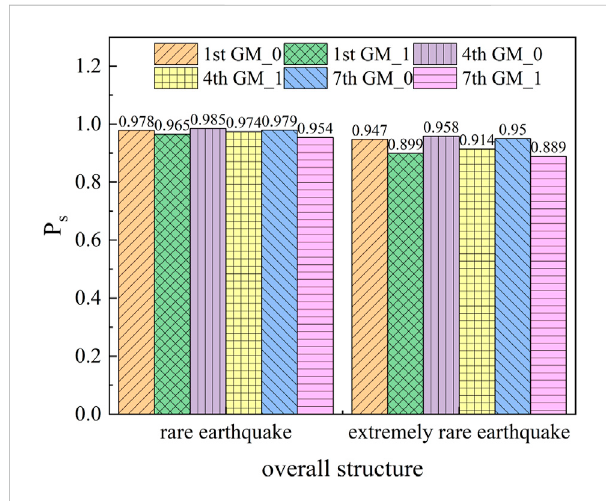
Comparison of overall reliability probability with different isolation layer